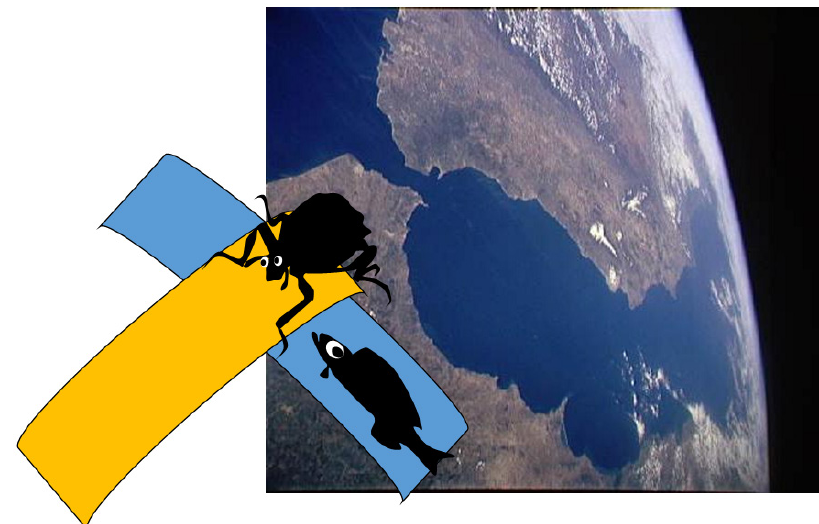
Figure 1. The images in the logo of the 9th Biennial Conference of the International Biogeography Society rotated, and a satellite image of the Strait of Gibraltar. Satellite Image Photograph by Nasavrs, available at https://pixels.com/featured/ strait-of-gibraltar-satellite-image-nasavrs.html, under a creative commons